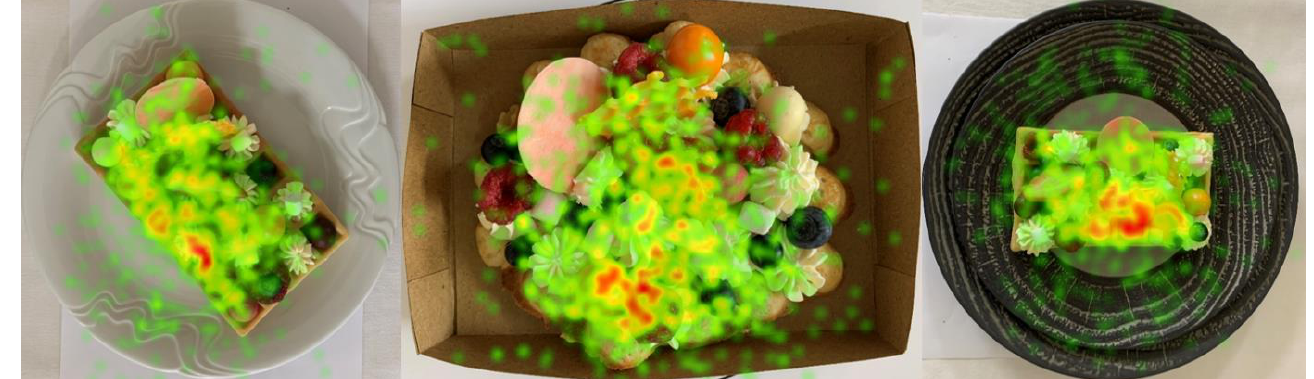
Figure 6. Thermal map of visual attention of waffles served in three different ways.